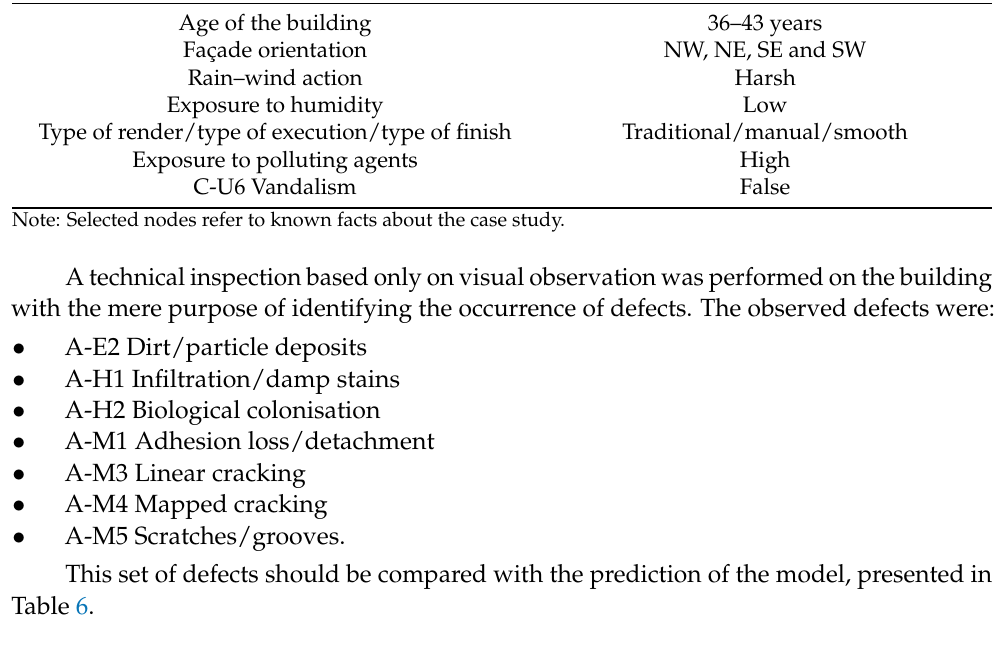
Table 6. Defect occurrence